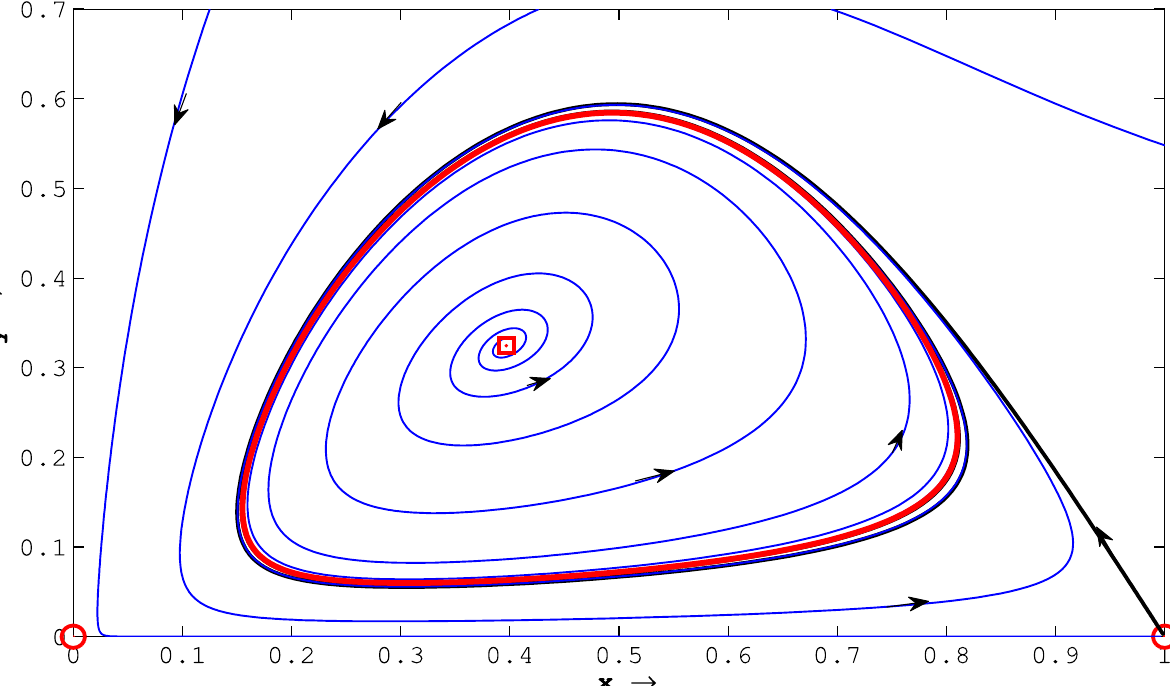
Figure 6. (Weak Allee effect:) the fixed points (0, 0) and (1, 0) are saddle points. These are shown with open circles. The single interior fixed point is locally unstable and shown with a square open box. This unstable equilibrium is surrounded by a stable limit cycle which is shown as a thick red curve. The limit cycle attracts the neighboring trajectories. The stable and unstable manifolds of (0, 0) are y and x axis, respectively. The stable manifold of (1, 0) is the x axis and its unstable manifold is shown by black curve. The considered parameters are l = − 0.01 ; β = 1.2 ; a = 0.5 ; b = 1.0 ; d = 0.3 .